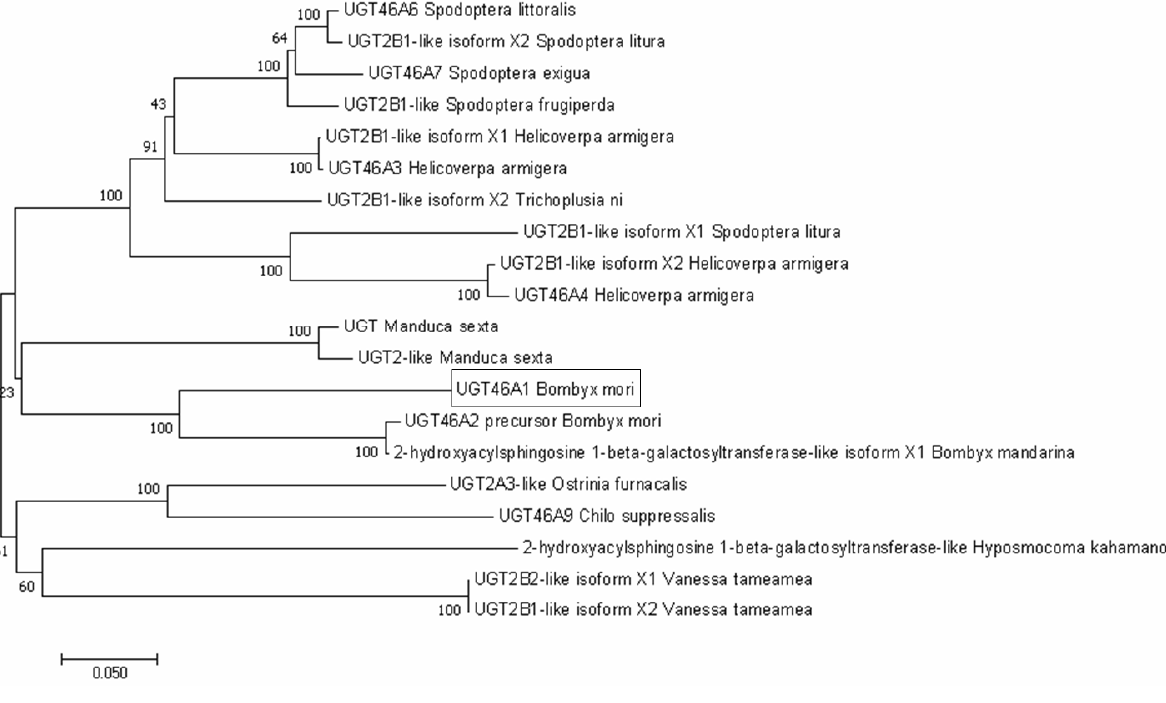
Figure 3. Phylogenetic tree of UGT46A1 and other homologous proteins. Neighbor-Joining tree was produced by MEGA7. One thousand bootstraps were performed for checking the reproducibility of the result.